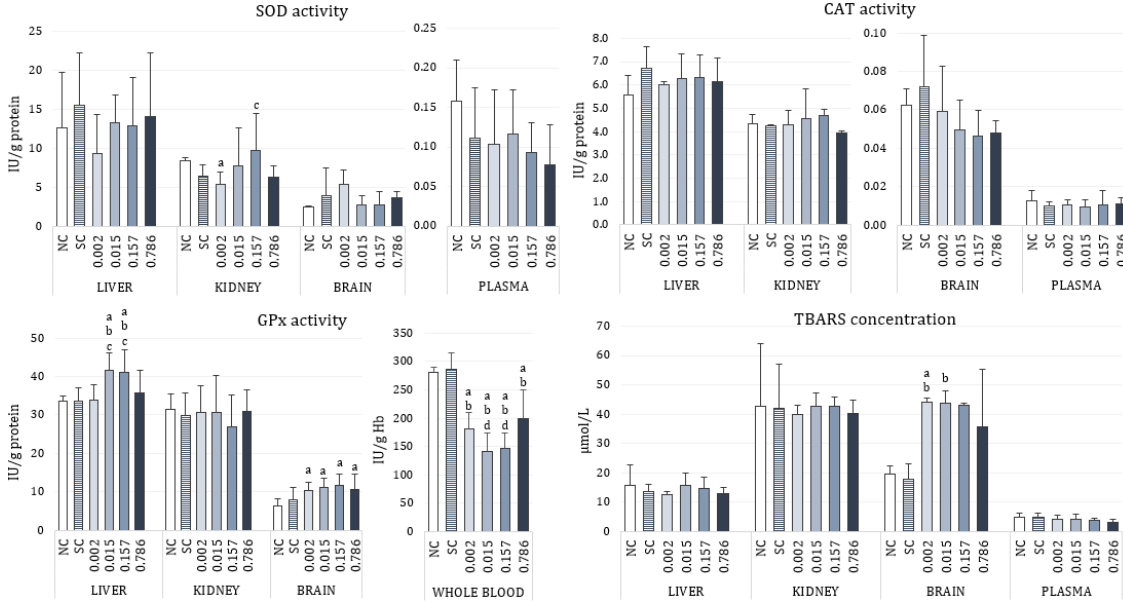
Figure 1. Changes of oxidative stress parameters in the liver, kidney, brain, and plasma/whole